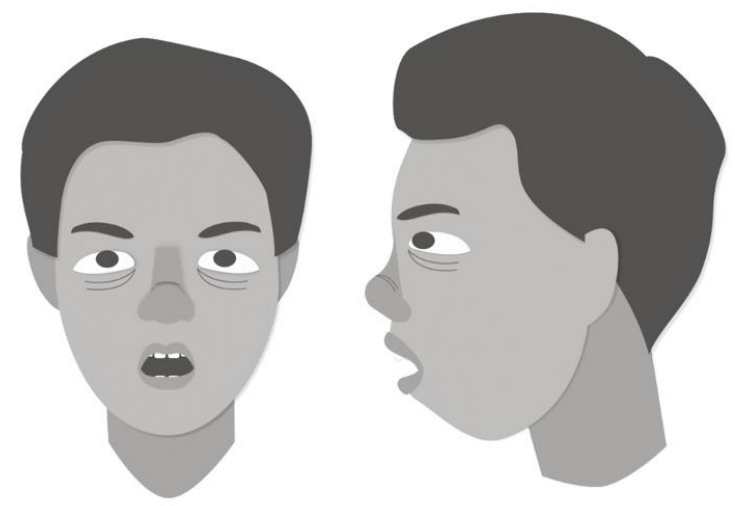
Figure 3. This child has “adenoid facies”, a term commonly used to describe facial characteristics of a mouth-breathing child with anterior face, retrusive mandible, sunken eyes, naroow pinched nostrils, and open mouth with crowded teeth [1].